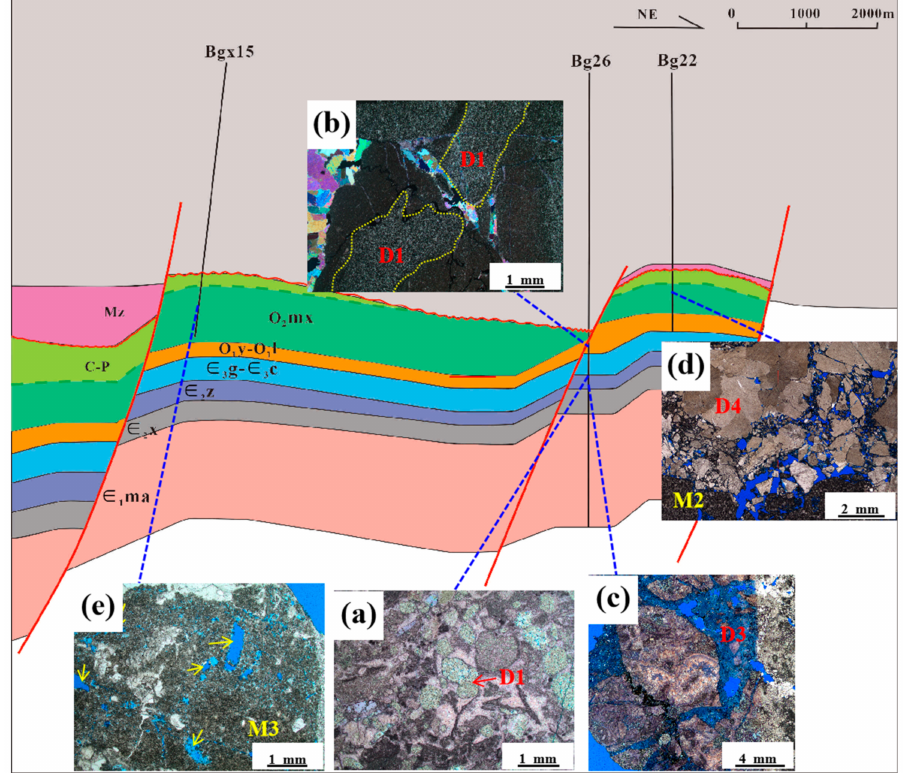
Figure 16. The difference of diagenesis between different wells. ( a ) Oolitic limestone, Well Bg26 2790.5 m, Zhangxia formation; ( b ) argillaceous limestone, well Bg26 2540 m, Yeli-Liangjiashan formation; ( c ) bioclastic limestone, well Bg26 2793.2 m, Zhangxia formation; ( d ) microcrystalline dolomite, well Bg22 2227.87 m Ordovician formation; ( e ) microcrystalline dolomite, well Bgx15 2238.9 m, Ordovician formation, moldic pores (yellow arrow); M2: microcrystalline dolomite; M3: fine-crystalline dolomite; D1: powder-to-fine-crystalline dolomite cement; D3: medium-to-coarse- crystalline dolomite cement; D4: saddle